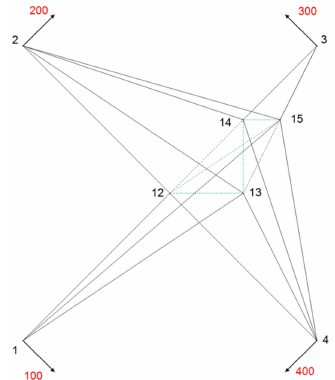
Figure 5. Situation of the theoretical geometric setting with the distances between connecting and new points, with missing connections between new points (dashed